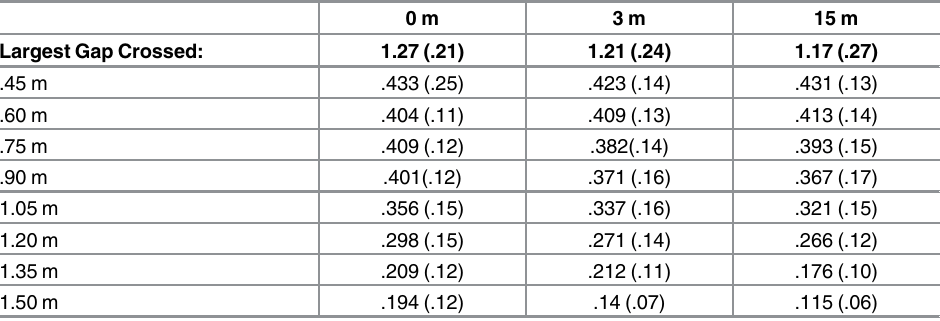
Table 2. Descriptives of Stepping